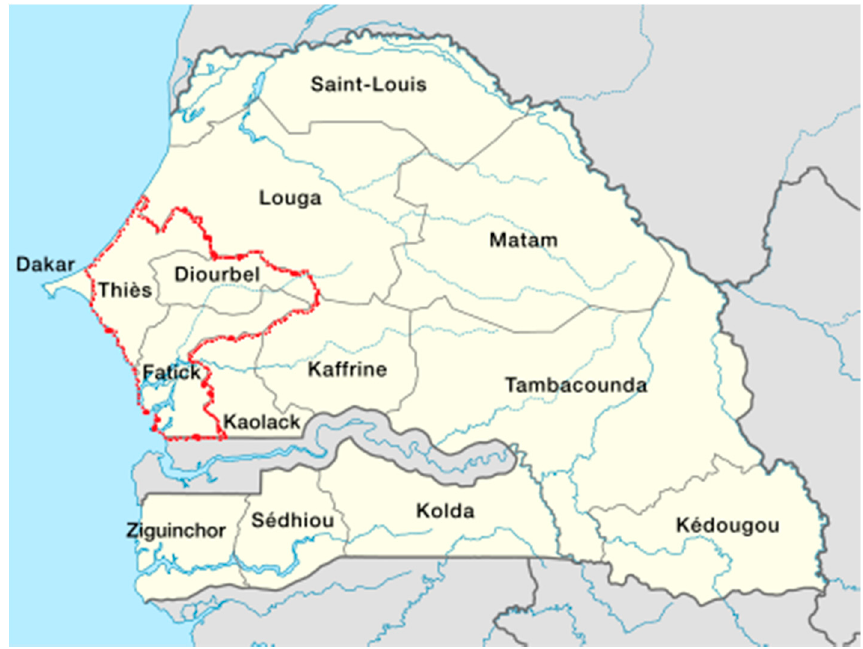
Figure 1. The three studied regions.